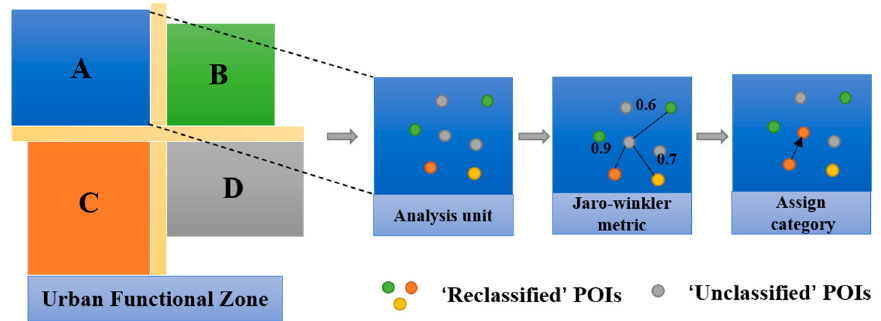
Figure 6. The workflow of the text similarity measurement.